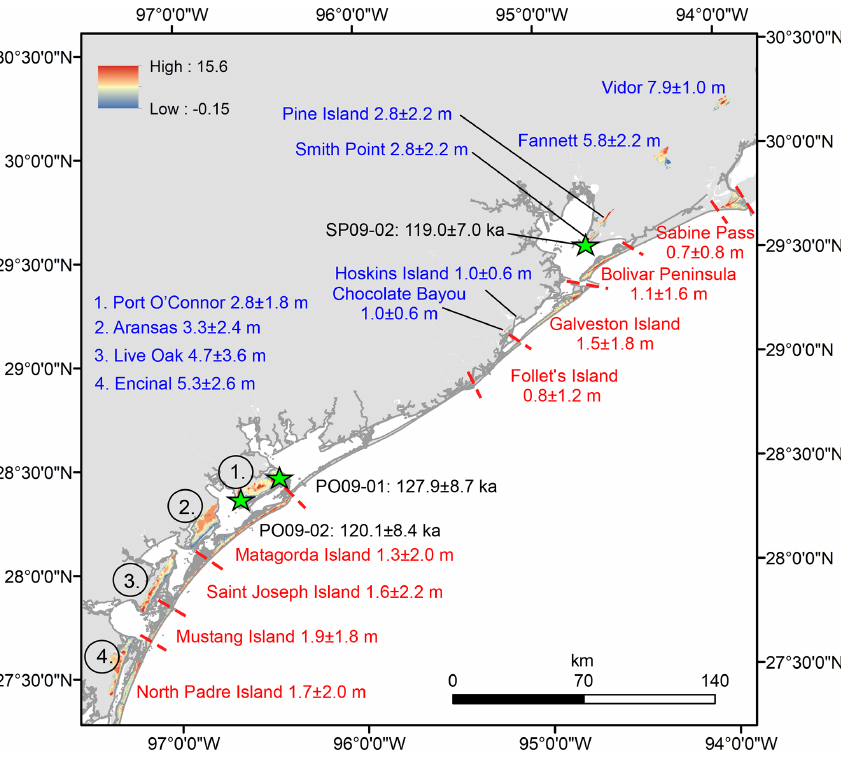
Figure 3. Map of the Texas coast of the northwestern Gulf of Mexico showing the locations of the LIG Ingleside shoreline segments (blue text) and modern barrier islands (red text) discussed in the text with their average elevations. Also shown as green stars and black text are the optically stimulated luminescence ages obtained from the Ingleside